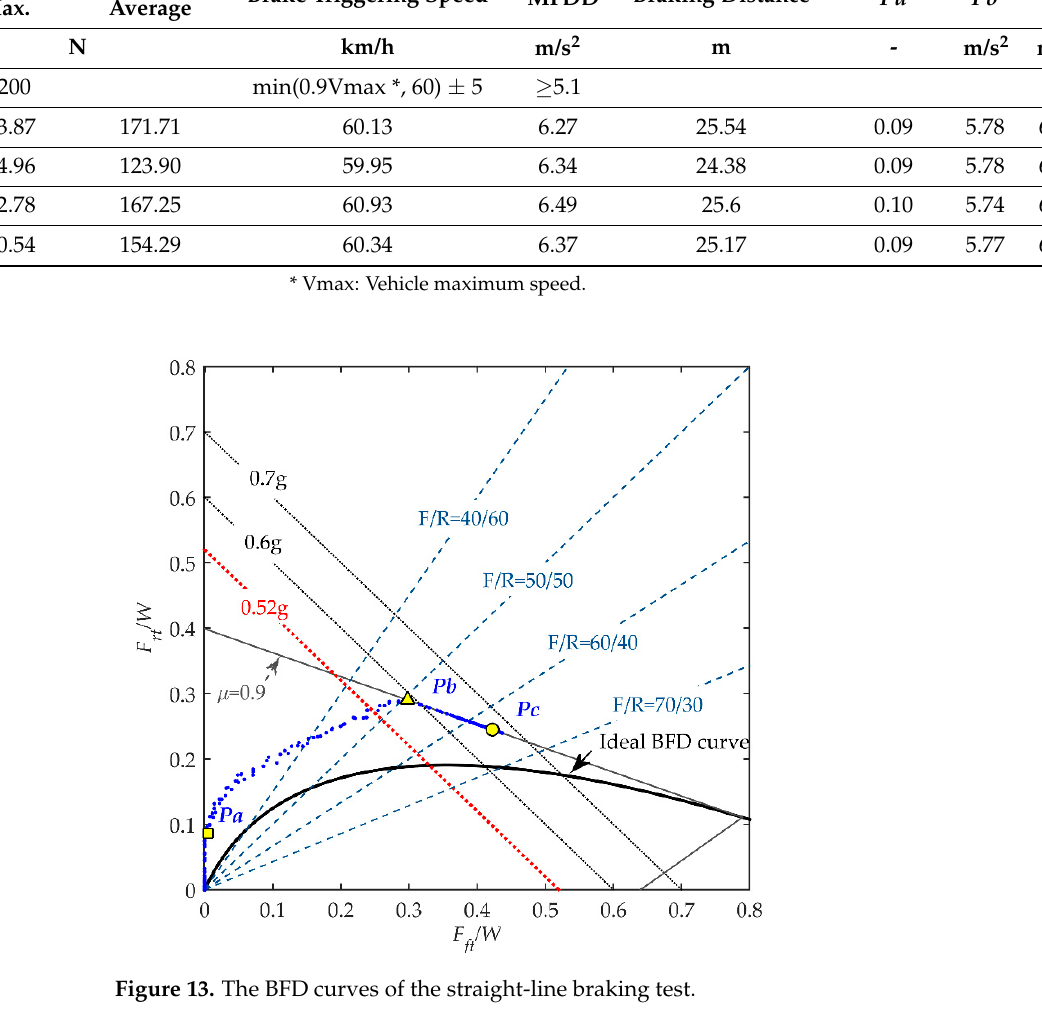
Table 3. Braking performance on front brake failure at laden load.